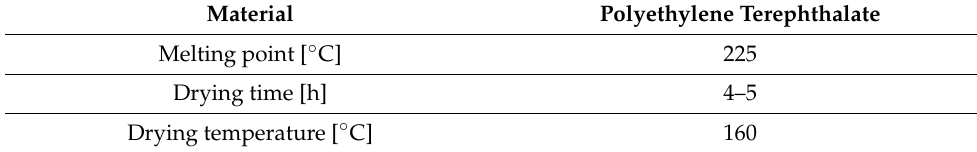
Table 2. Thermal properties of PET.